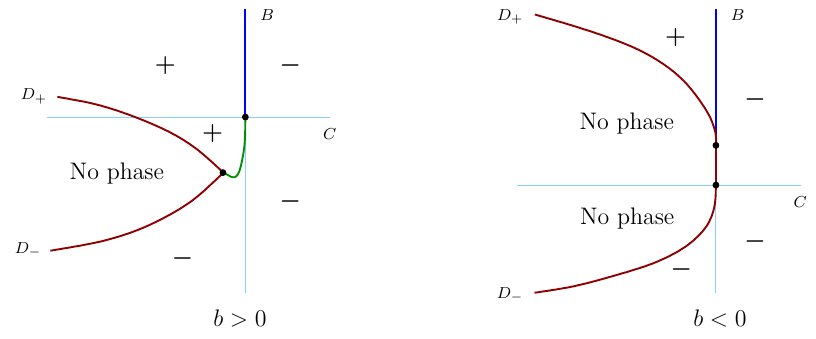
Figure 32 . Phase diagram for Case III: A < 0 , A + a < 0 . Refer to the caption of figure 26 for details on the various marked